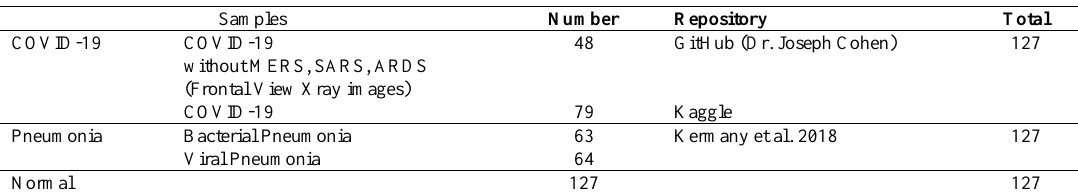
Table 2. Detail of dataset